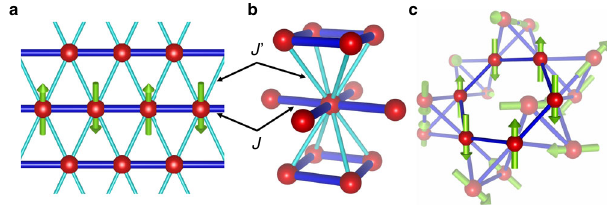
spheres represent FeO 6 octahedral units, AsO 4 tetrahedral units, oxygens, and hydrogens of water molecules, respectively. The red, blue, and green arrows indicate the crystallographic a , b , and c axes, respectively. Four FeO 6 octahedra with small trigonal distortions are connected by their edges to form a cluster of T d symmetry, forming a regular tetrahedron made of Fe 3 + ions. These clusters are located at the vertices of the cubic unit cell with ~8Å on each edge and connected to neighbours via a [AsO 4 ] 3 − tetrahedron along the edge of the cube. The cube possesses a large open space at the centre, which accommodates various large monovalent ions, a hydronium ion in this case, and water molecules. b Fe sublattice and the q = 0, Γ 5 magnetic structure below T N = 6K. Red spheres represent spin-5/2 Fe 3 + ions, four of which form a regular tetrahedral cluster at each vertex of the cubic unit cell. The yellow green arrows represent the directions of the magnetic moments of Fe spins, all of which lie approximately in the planes perpendicular to the c axis. The thick blue and thin sky-blue sticks represent intracluster Heisenberg interactions J and intercluster Heisenberg interactions J ’ ,